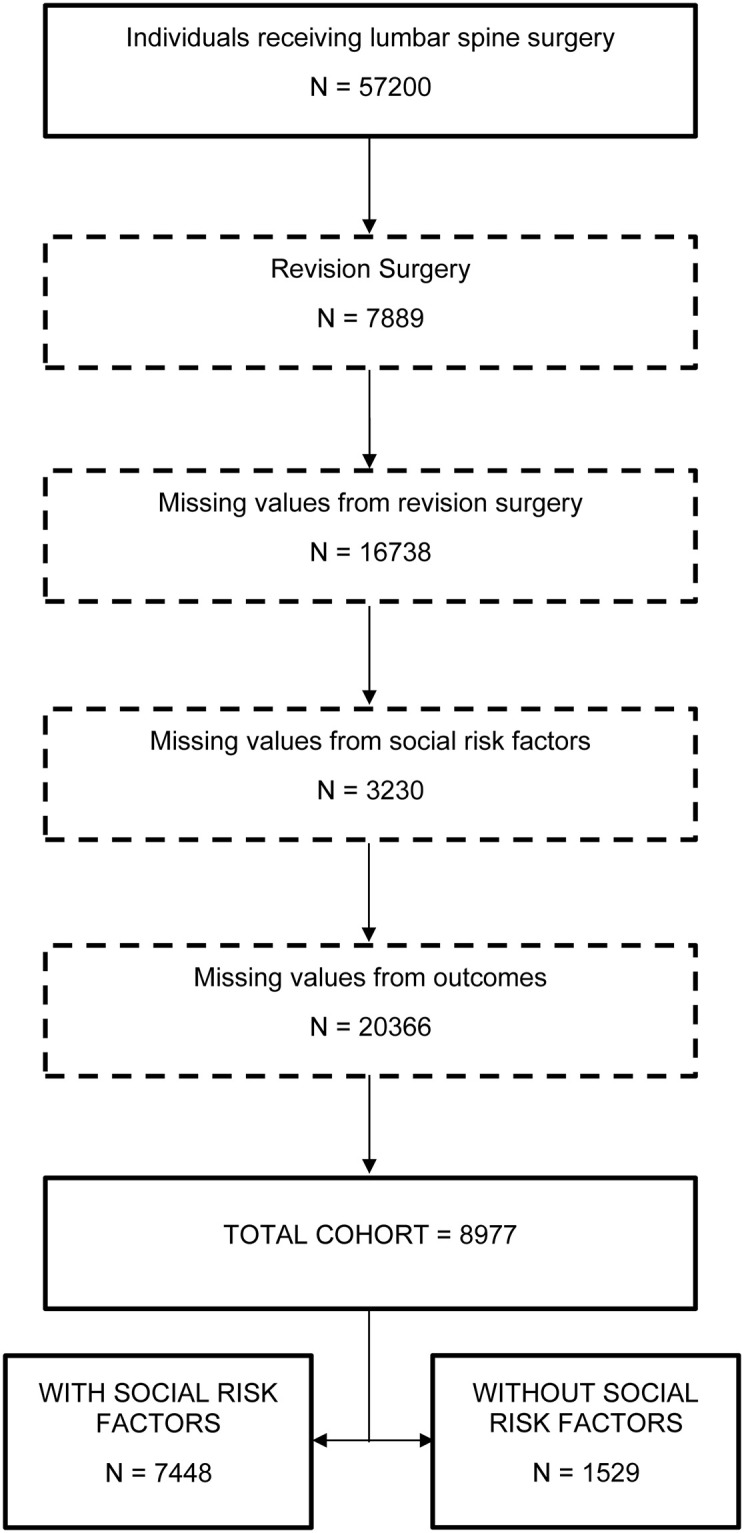
Cohort selection process.